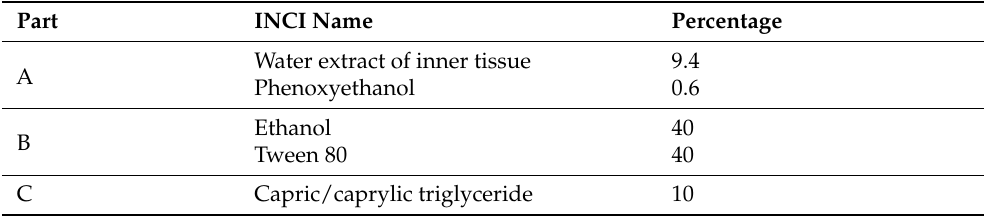
Table 2. The ingredients of the